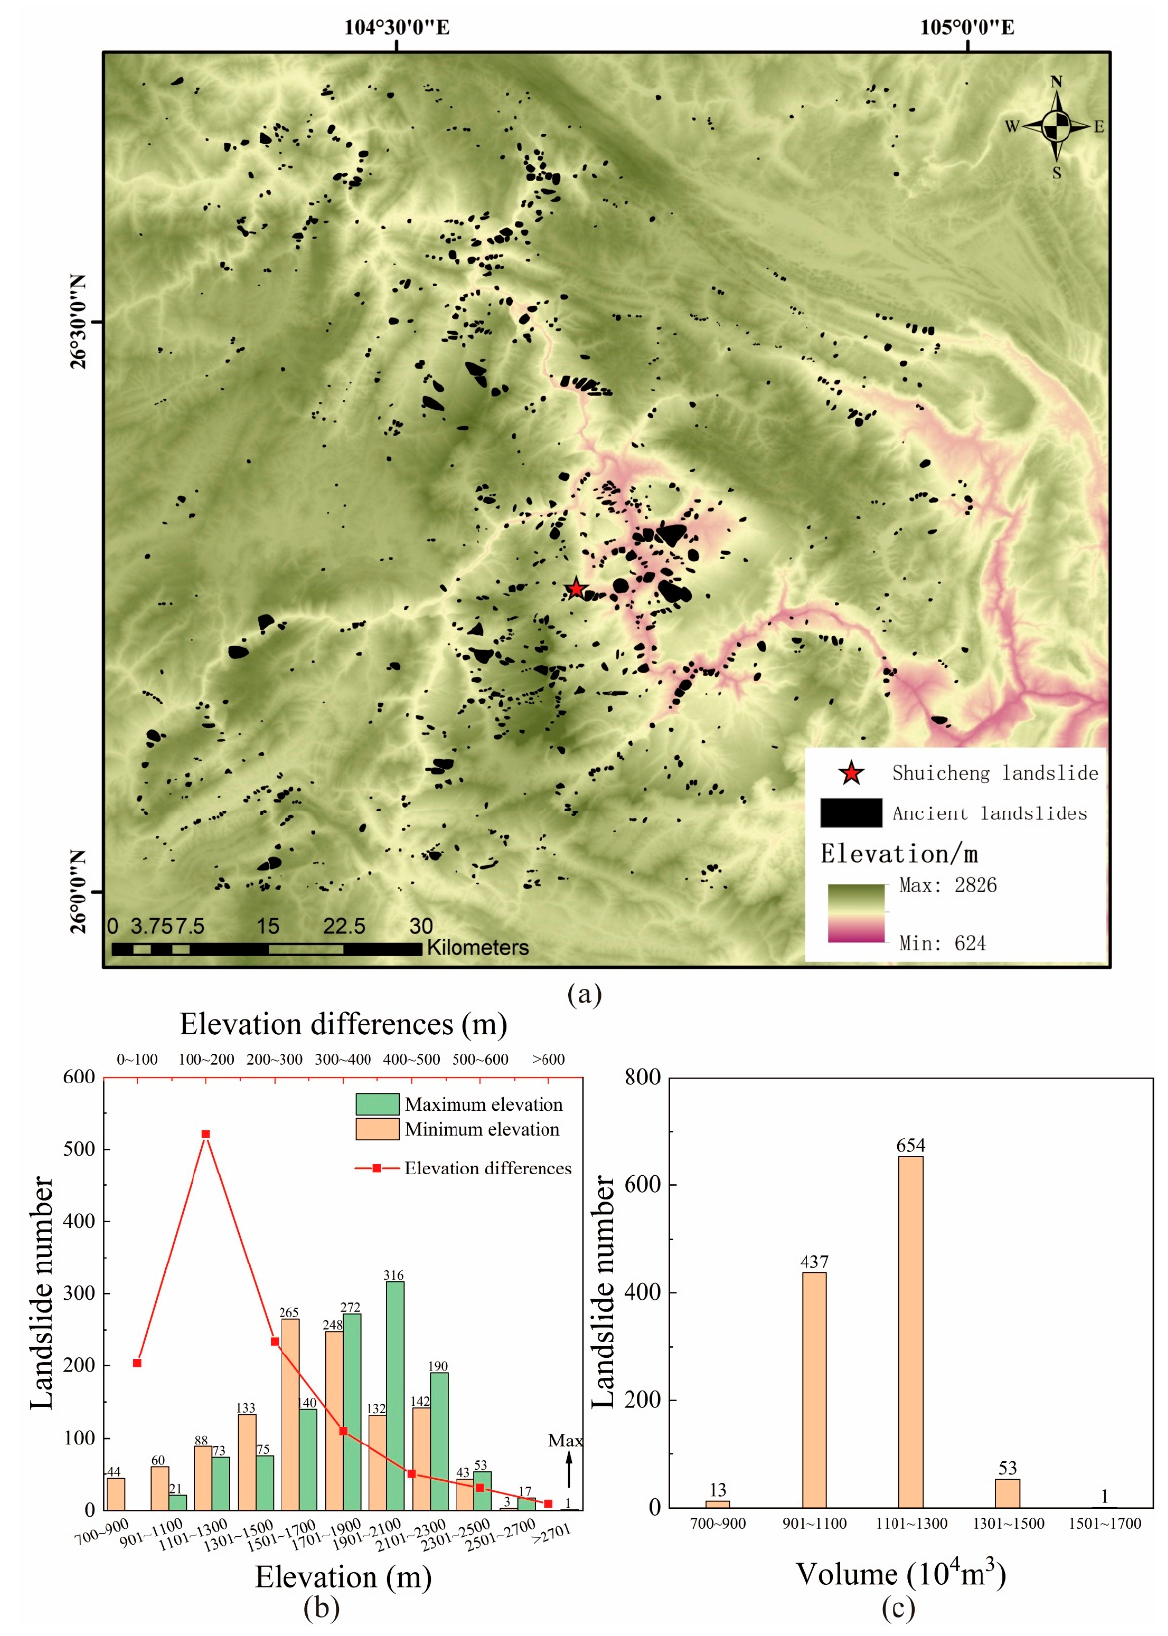
Figure 7. ( a ) Shaded terrain map showing ancient landslides around the Shuicheng landslide. ( b ) Number of ancient landslides versus elevations of top (Maximum) and toe (Minimum) of slope and elevation differences. ( c ) Number of ancient landslides versus their volumes.